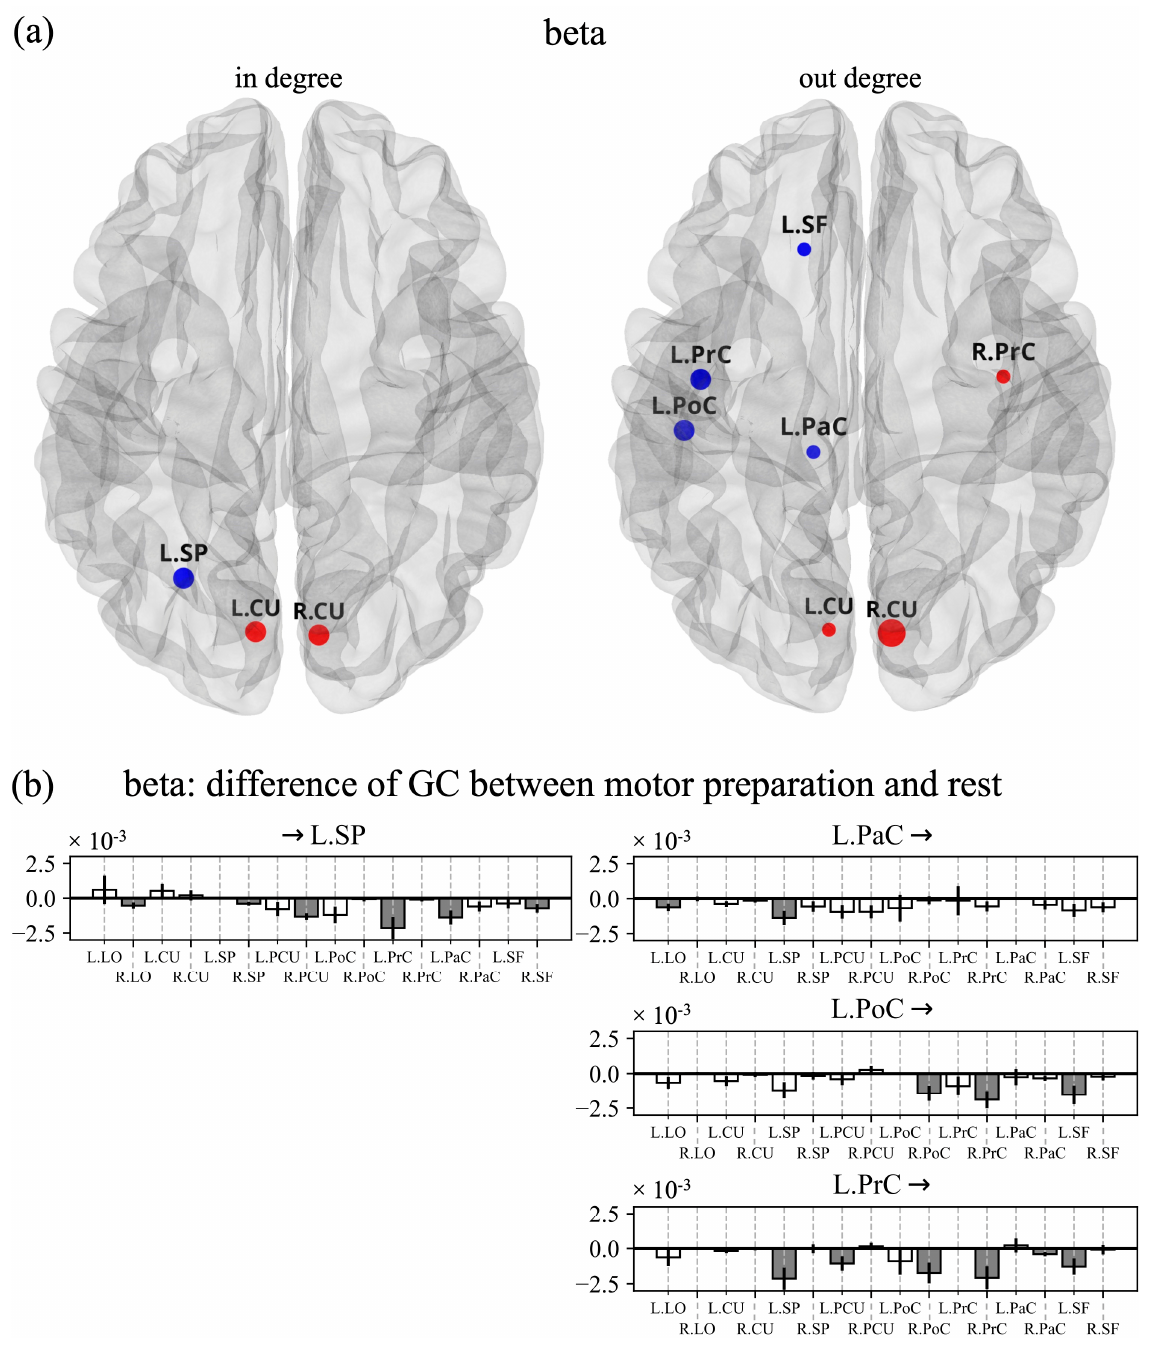
Figure 7. ( a ) ROIs with a significantly different in degree (left panel) and out degree (right panel) during reaching movement preparation compared to rest in the beta band. ( b ) Each bar plot shows, for a selected ROI among the ones in panel a, the difference in the connections (movement preparation— rest) entering in the selected ROI from all other ROIs or exiting from the selected ROIs towards all other ROIs. See the caption of Figure 6 for further